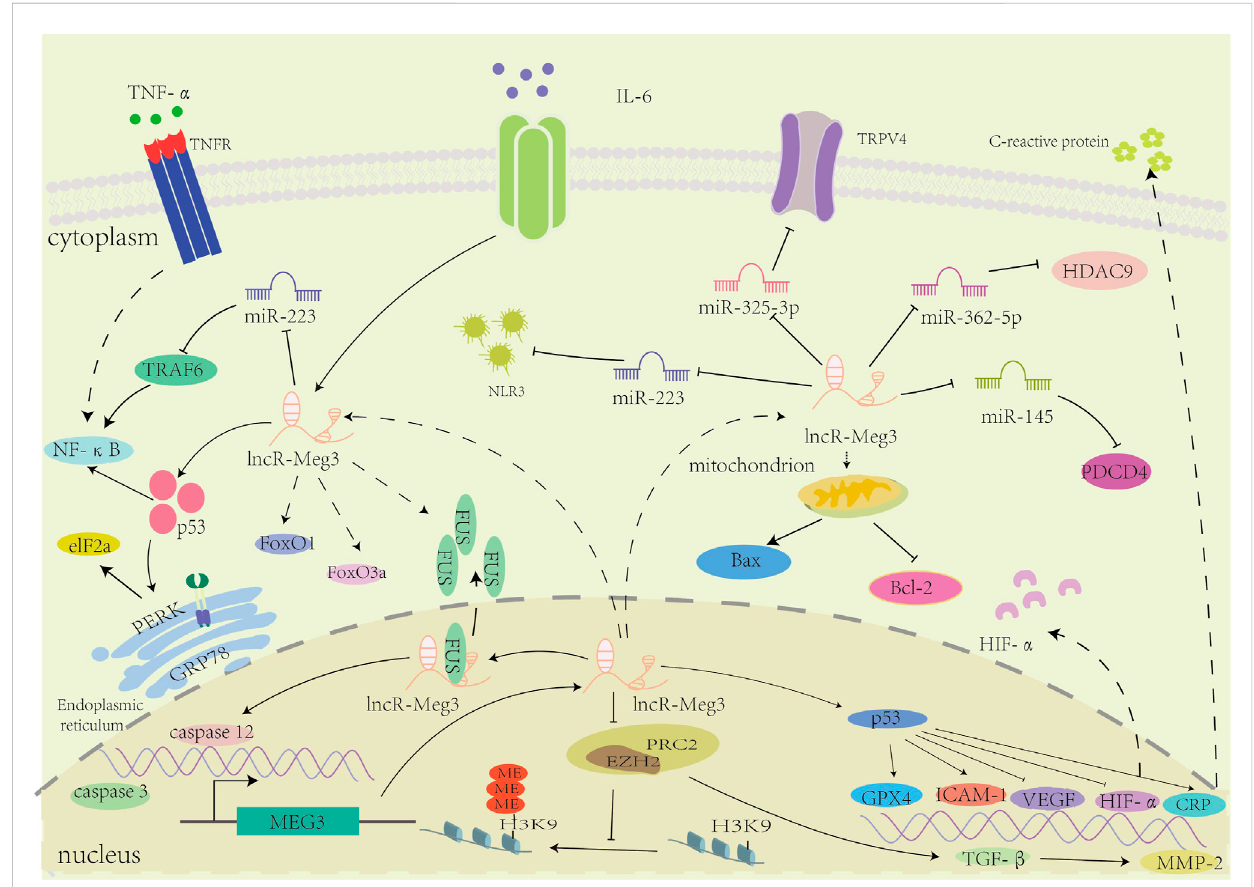
FIGURE 3 The mechanisms of involvement of lncR-Meg3 in cardiovascular diseases. LncR-Meg3 regulates cardiovascular diseases through diverse mechanisms.BydirectlyinteractingwithdifferentmiRNAs,lncR-Meg3regulatestheexpressionoftargetgenesorproteins,facilitatingtheprogressionof diseases. In nucleus, the PRC2 subunit EZH2 mediates the methylation of H3 thereby regulating the gene ’ s